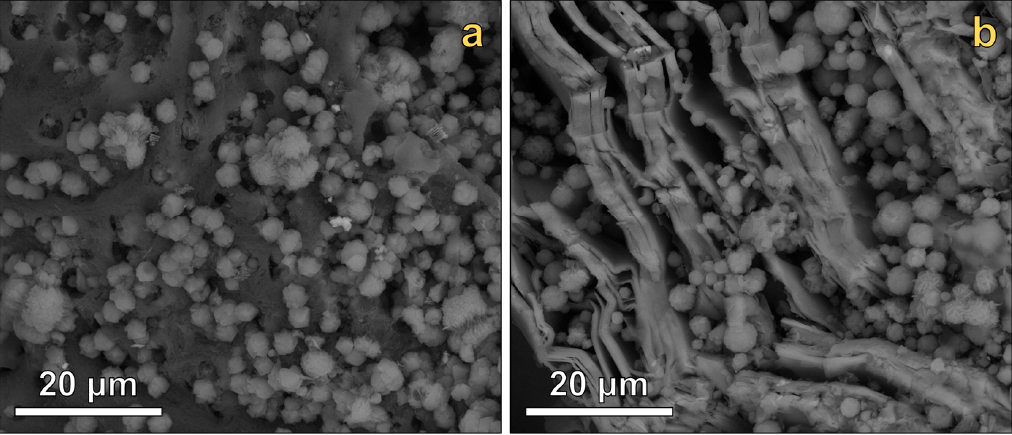
Figure 4. SEM images of composite zeolites: NaX–C ( a ), and NaX–Ver ( b